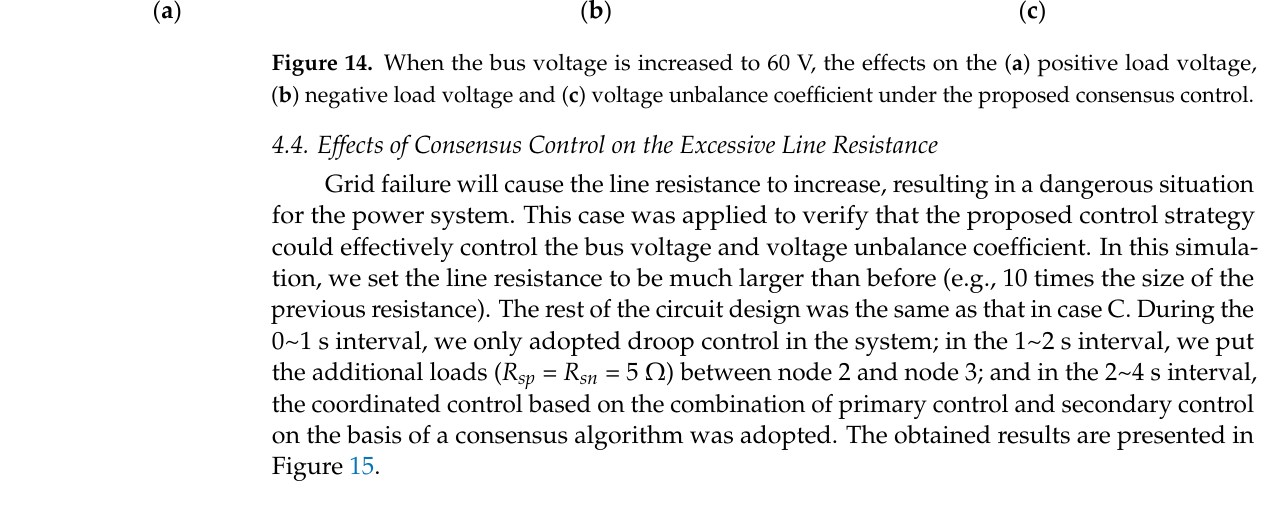
Figure 14. When the bus voltage is increased to 60 V, the effects on the ( a ) positive load voltage, ( b ) negative load voltage and ( c ) voltage unbalance coefficient under the proposed consensus control.